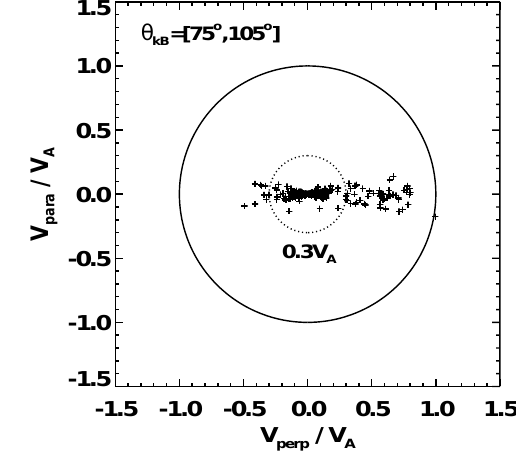
Fig. 11. Friedrichs diagram of perpendicular propagating wave events that are identified as standing structures ( V ph < 0 . 3 V A ) and perpendicular propagating fluctuations ( V ph > 0 . 3 V A